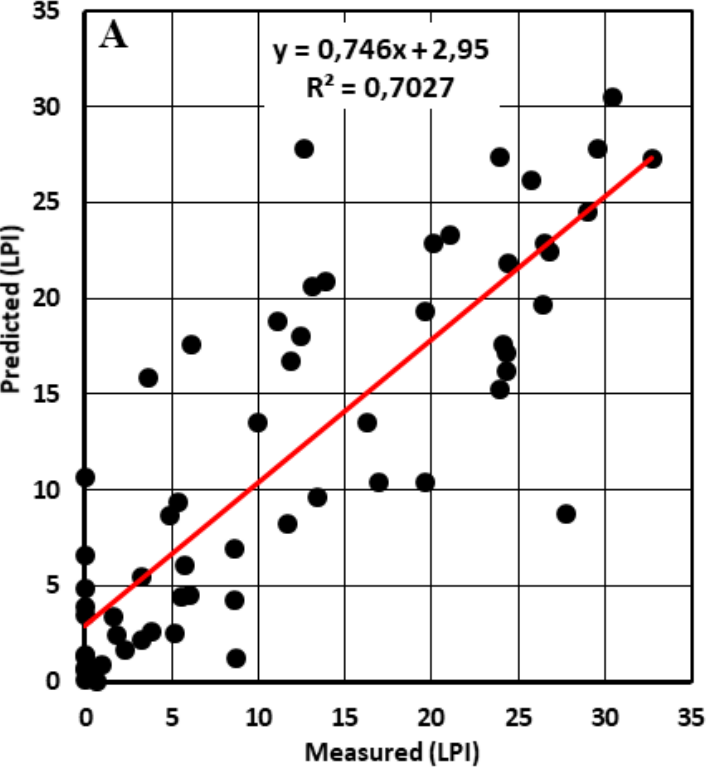
Figure 8: Cross validation of the semivariogram model for the liquefaction potential index (isotropic analysis A, anisotropic analysis